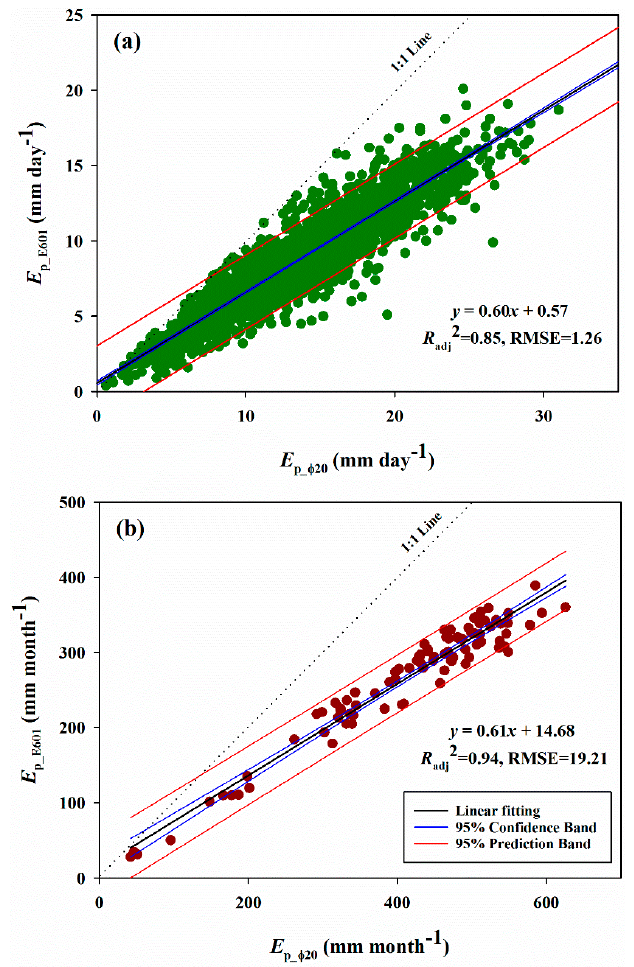
Figure 2. Relationship between pan evaporation of φ 20 ( E p_ φ 20 ) and E601 ( E p_E601 ): ( a ) Daily (mm·day − 1 ); ( b ) Monthly (mm·month − 1 ) time scale for Ejin station during the unfrozen period from 1986 to 2001. The linear fitting, 95% confidence band, prediction band line, and value of regression analysis are shown. Table 1. Monthly change of climatic variables included the mean ( T mean , °C), maximum ( T max , °C), minimum ( T min , °C) of air temperature, precipitation ( P , mm), relative humidity ( RH , %), sunshine duration ( S d , h), wind speed ( U , m s − 1 ), and pan evaporation ( E p , mm) at Ejin station over the past 60 years (1957–2016).